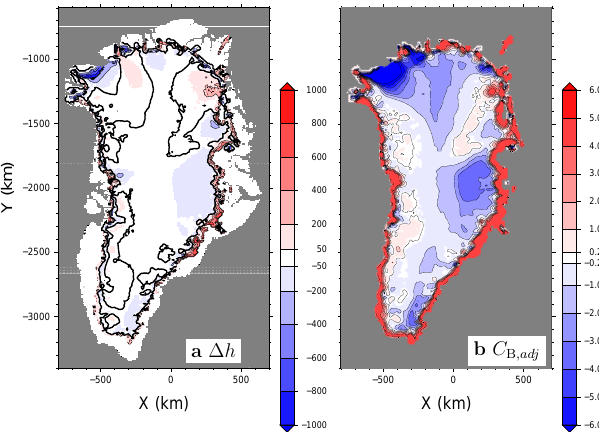
Figure 5. The result of the “inversion” procedure: (a) difference in the surface elevation (m) relative to the present-day observation and (b) “inverted” basal-sliding coefficient field in terms of fraction relative to the value of the case v2 in logarithmic